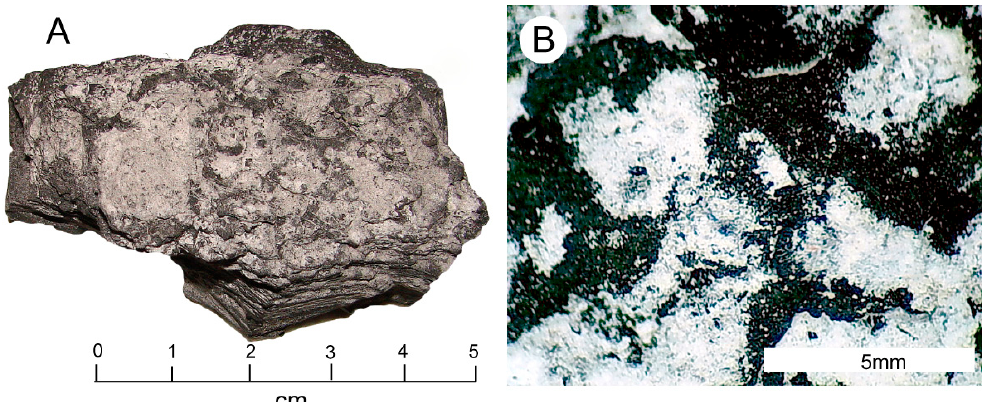
Figure 10. Carbonaceous sample containing light-colored ncrustrations. ( A ) β -Radiation intensity of the upper surface is low, β = ~100 CPM ( B ) Reflected light photomicrograph showing white patches of aluminum sulfate.